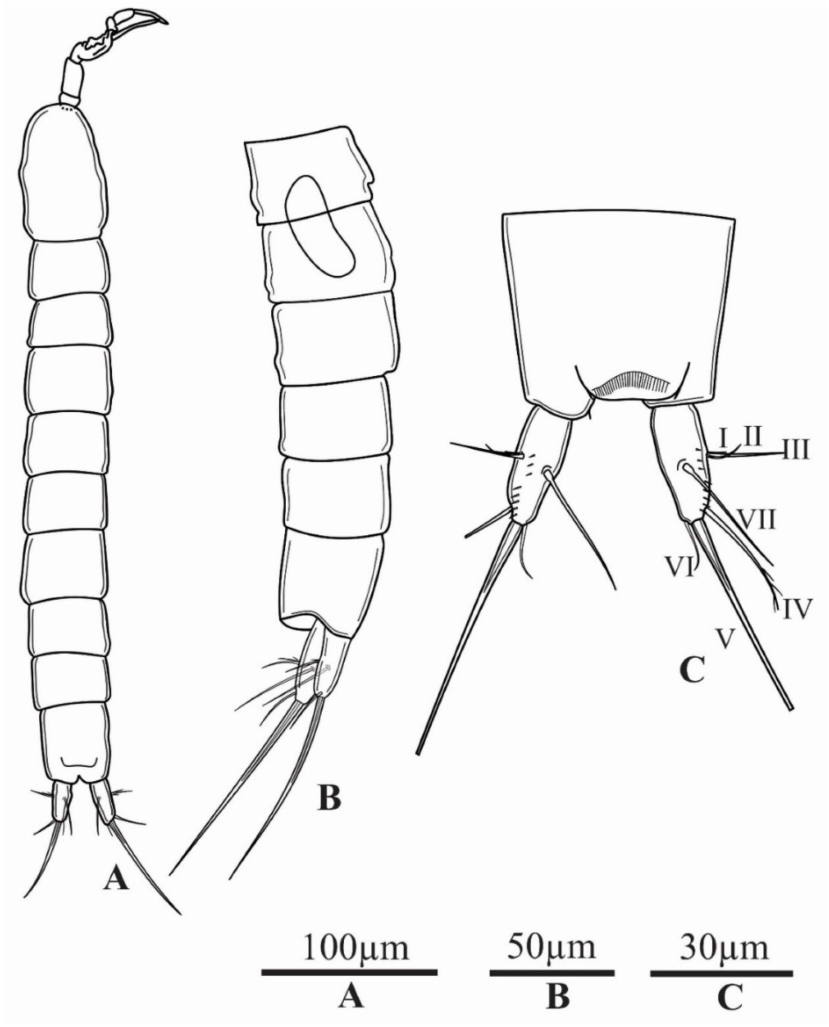
Figure 7. Parastenocaris sontraensis sp. nov. male. ( A ), habitus dorsal view; ( B ), urosome lateral view; ( C ), anal somite with furcal